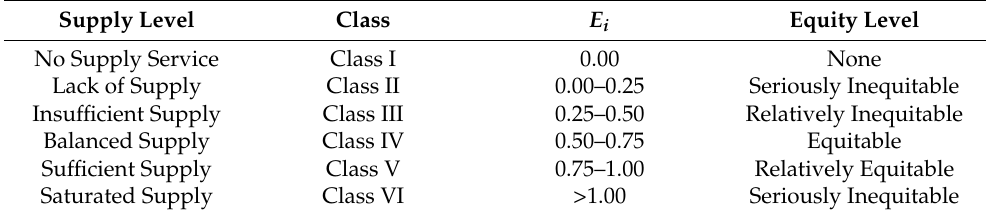
Table 3. Supply level and equity level classification